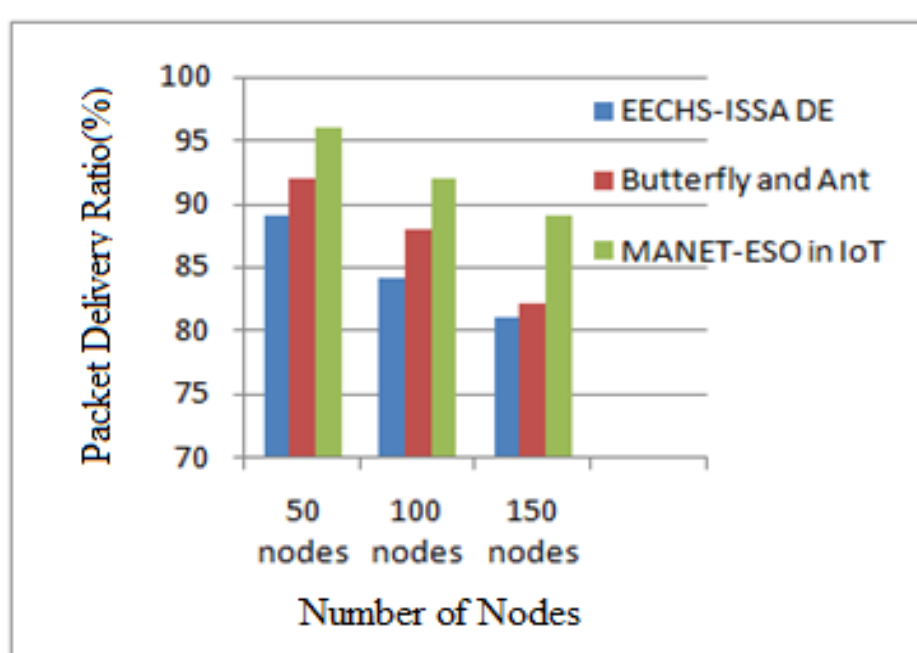
Figure 5. Packet Delivery Ratio vs. Number of Nodes.